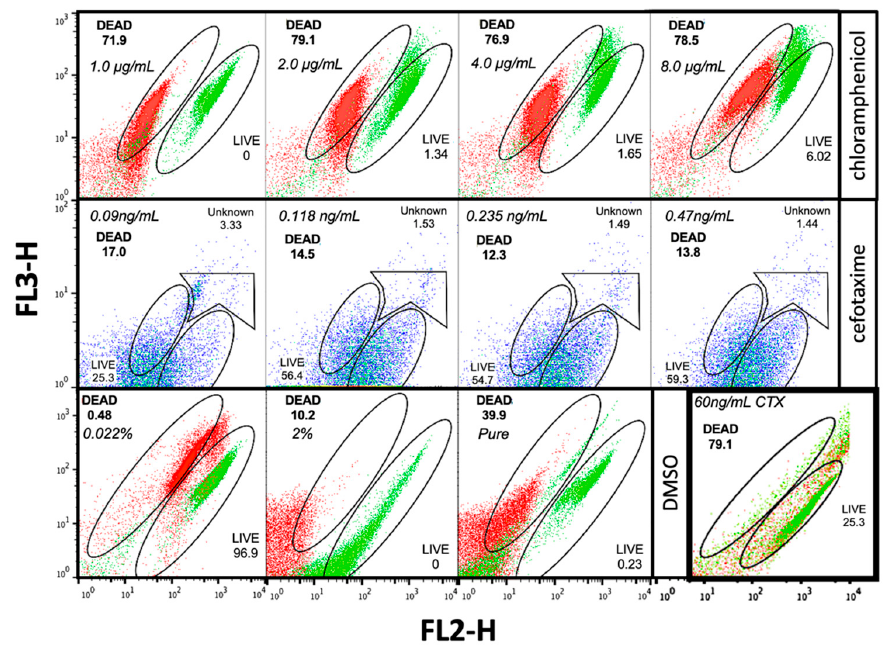
Figure 3. Standard antibiotics determination. Dot plots for the treatment of E. coli with chlorampheni- col (upper panels), cefotaxime (middle panels) and DMSO (lower panels). phenicol (upper panels), cefotaxime (middle panels) and DMSO (lower